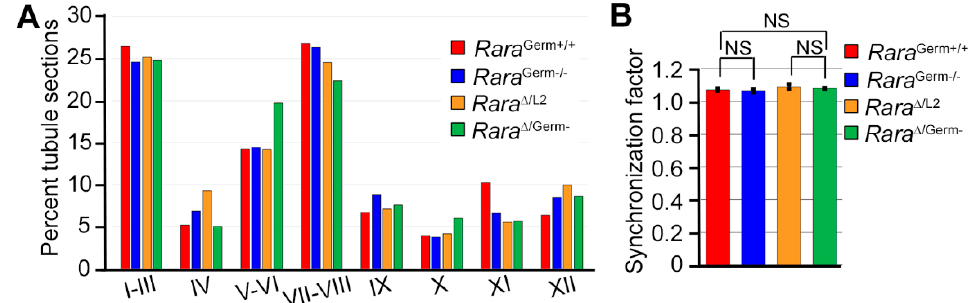
Figure 3. The distribution of the stages of the seminiferous epithelium cycle was normal in mutants lacking RARA in germ cells. ( A ) Relative frequencies of the 12 stages of the seminiferous epithelium cycle (I to XII) in control ( Rara Germ+/+ , red bars), heterozygote ( Rara ∆ /L2 , orange bars), and mutant ( Rara Germ − / − , blue bars; Rara ∆ /Germ − , green bars) mice. ( B ) Calculated synchronization factors. Error bars represent standard deviations (n = 10 for Rara Germ+/+ ; n = 3 for other genotypes). NS, not statistically significant.